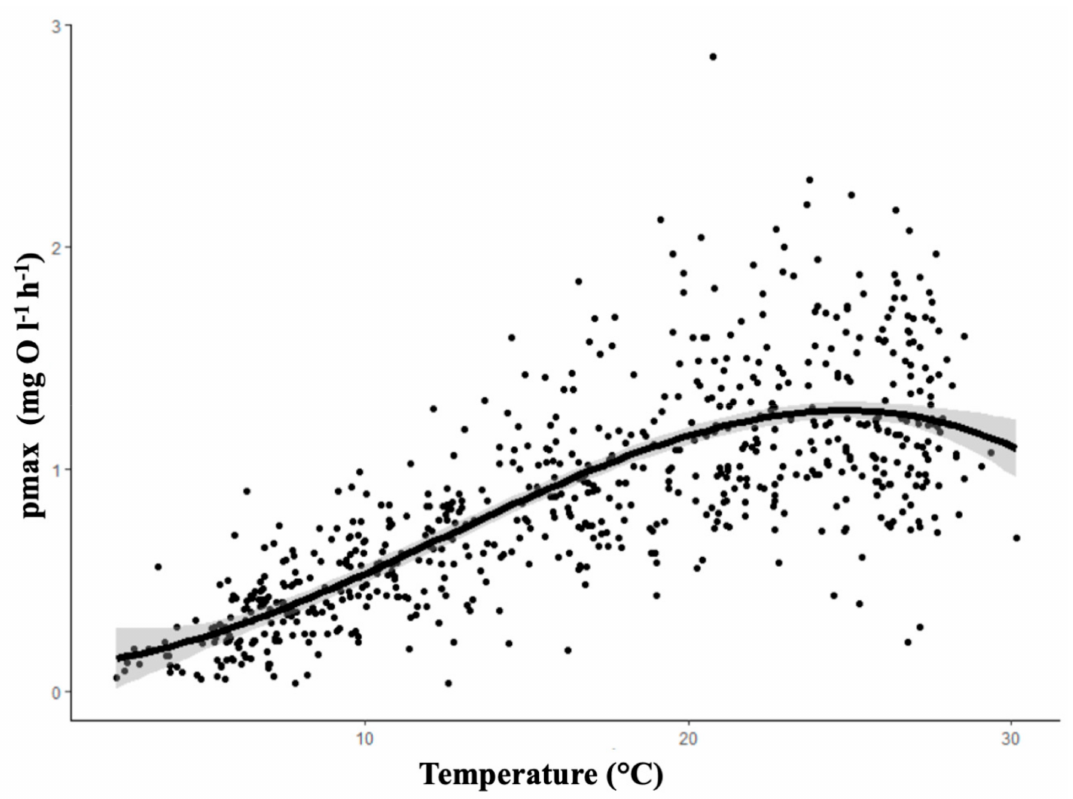
Figure 5. Relationships between temperature and pmax .